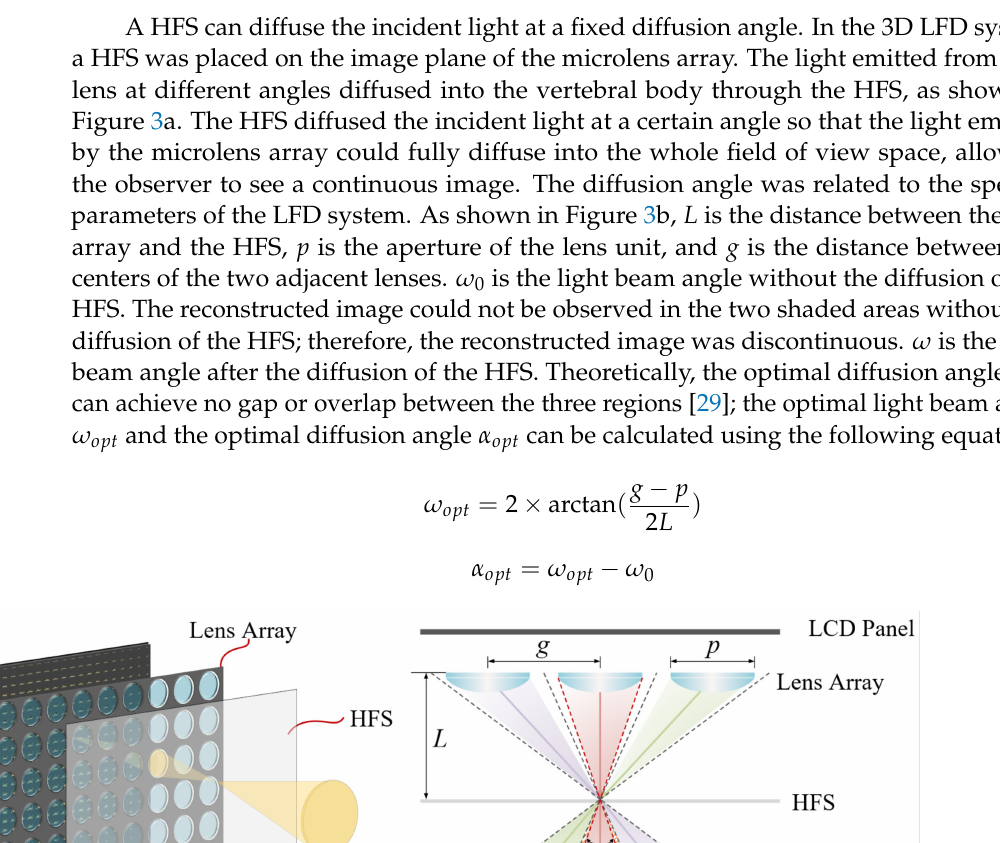
Figure 2. Diffusion effects ( a ) without a HFS, ( b ) of a HFS with a 1.5 ◦ diffusion angle, and ( c ) of a HFS with a 3 ◦ diffusion angle.